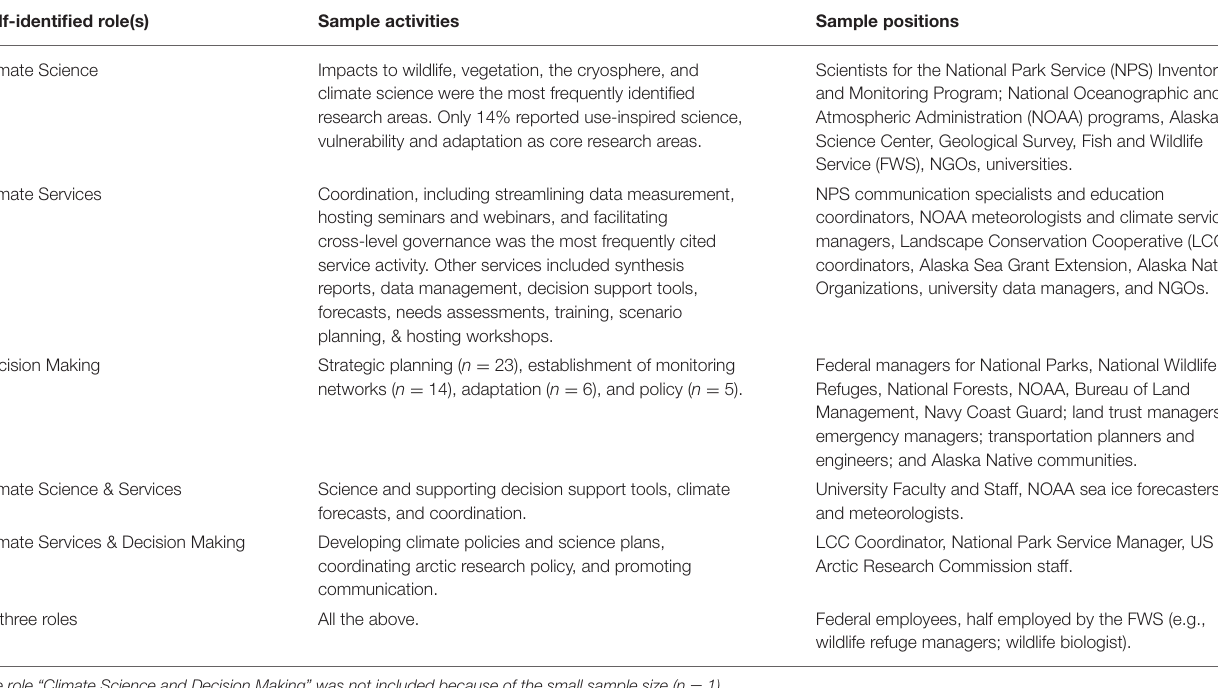
TABLE 1 | Participant engagement in Climate Science, Climate Services, and Decision-making in Alaska, including sample activities and prominent positions. Self-identified role(s)